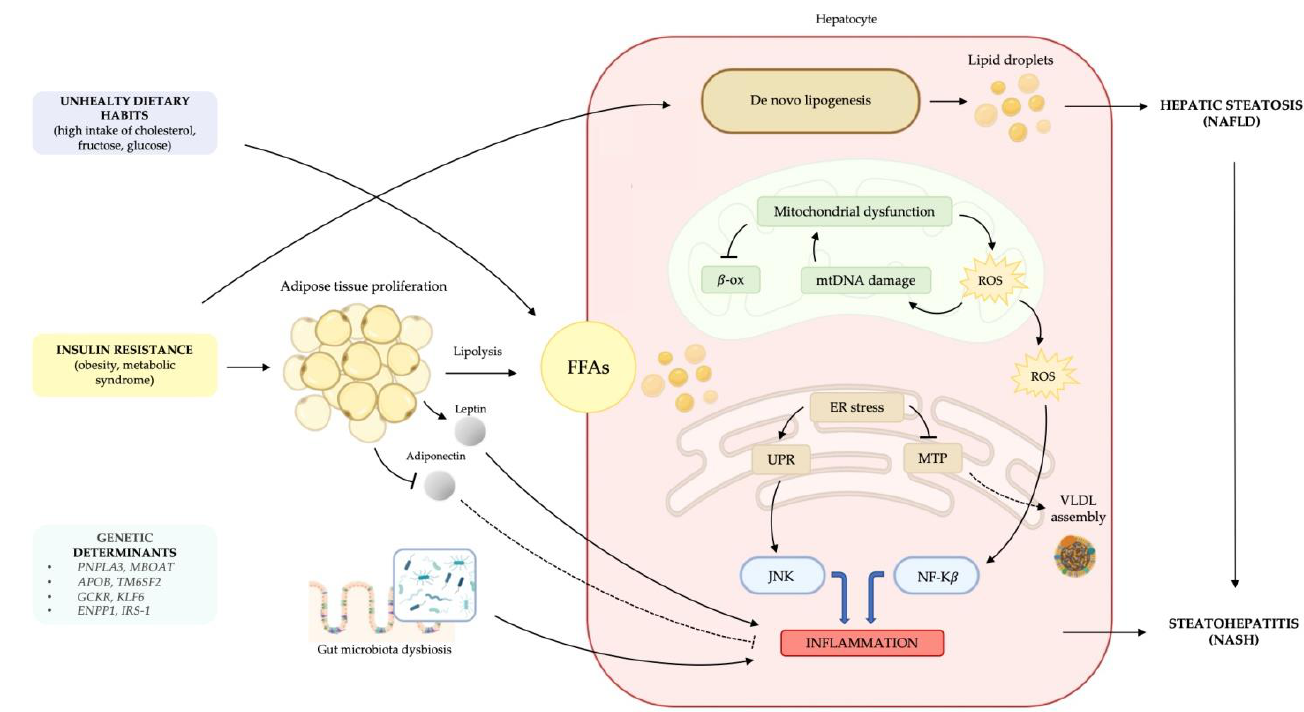
Figure 1. Pathogenesis of non-alcoholic fatty liver disease. The complex interplay between environmental, genetic, and metabolic factors results in an imbalance between intrahepatic lipid retention and disposal. Increased FFAs uptake derives from both high fat diet and adipose tissue lipolysis. Peripheral insulin resistance promotes adipose tissue proliferation and adipocyte disfunction, induces lipolysis and release of adipokines, namely leptin and adiponectin with pro-inflammatory effects. Insulin resistance also determines an increase in hepatic de novo lipogenesis, worsening lipid liver accumulation. Toxic lipid species cause mitochondrial dysfunction, oxidative stress with ROS production and ER stress leading to the activation of UPR response. All these processes are involved in the activation of an inflammatory response through JNK e and NF- κβ pathways. Gut microbiota dysbiosis is also implicated in hepatotoxic oxidative damage. Abbreviations: FFAs, free fatty acids; β -ox, beta oxidation; mtDNA, mitochondrial DNA; ROS, reactive oxygen species; ER, endoplasmic reticulum; UPR, unfolded protein response; MTP, microsomal triglyceride transfer protein; JNK, c-Jun N-terminal kinase; NF-K β , nuclear factor kappa-light-chain-enhancer of activated B cells; VLDL, very low-density lipoprotein; NAFLD, non-alcoholic fatty liver disease; NASH, non-alcoholic